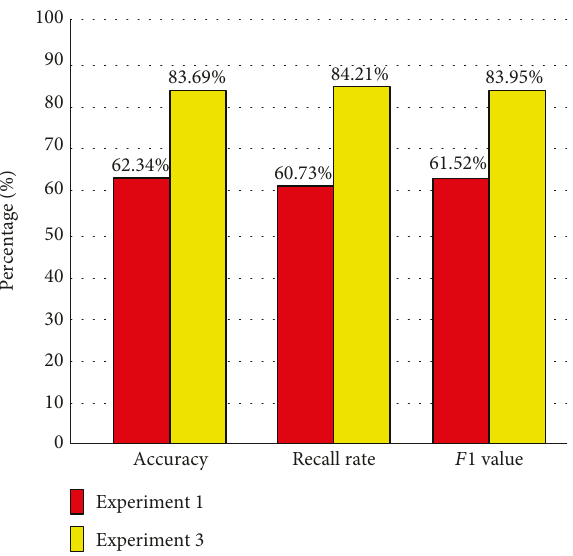
Figure 3: Comparison of Experiment 1 and Experiment